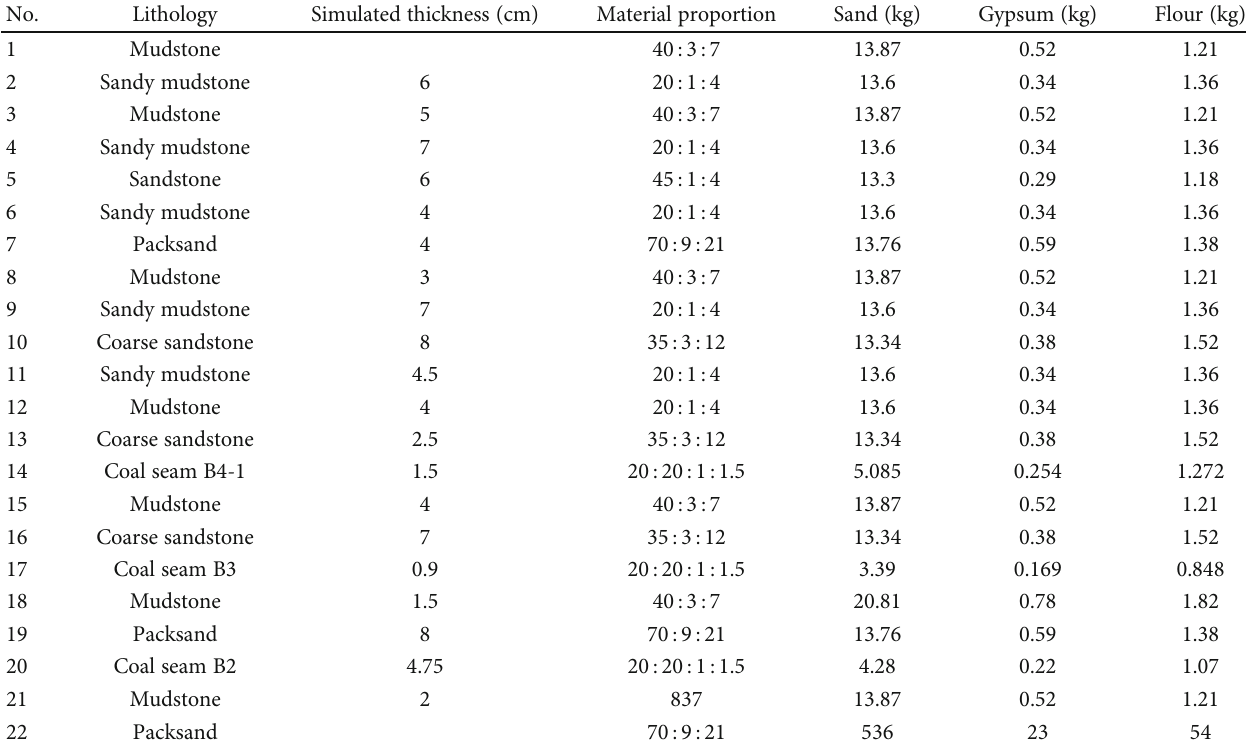
Table 3: Experiment ratio.